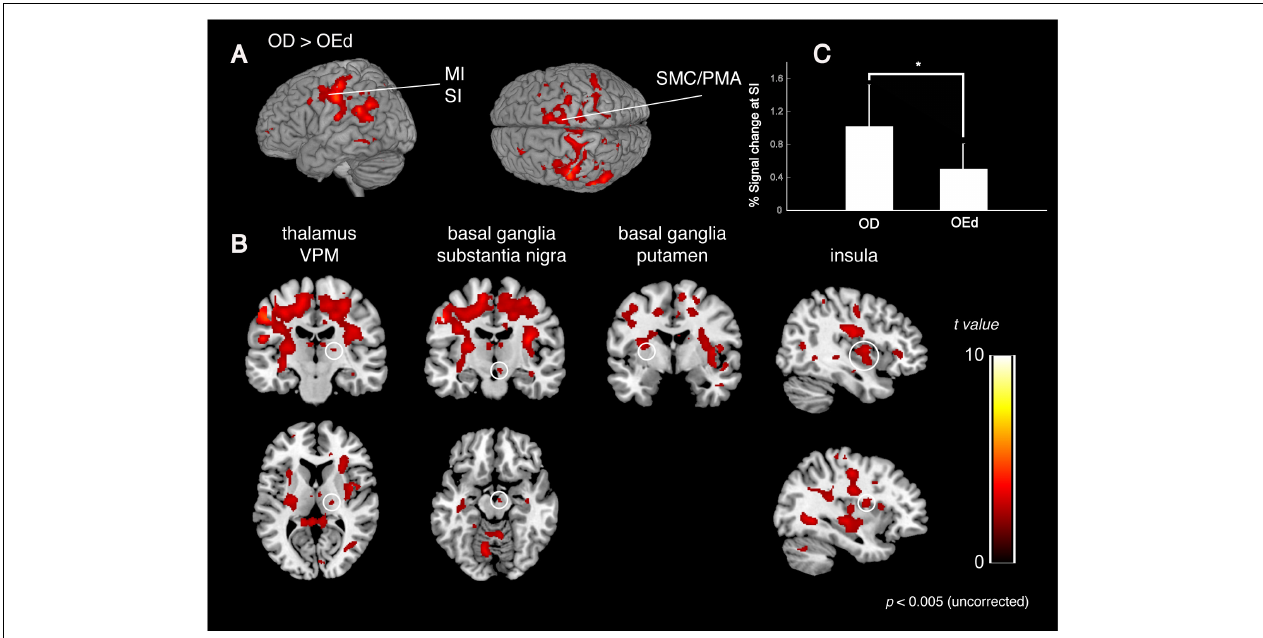
FIGURE 5 | Comparison between OD and OEd groups. (A,B) Results from group comparisons between OD and OEd (OD > OEd) are shown. Activated areas were decreased in the MI, SI, thalamus (VPM), basal ganglia, and insula cortex ( p < 0.005, uncorrected). The color bar shows the t -values. (C) The reduction of BOLD response strengths in the SI (* p < 0.05). The reduction of representation areas and BOLD response strengths can be related to missing teeth, which leads to reduced periodontal afferents.